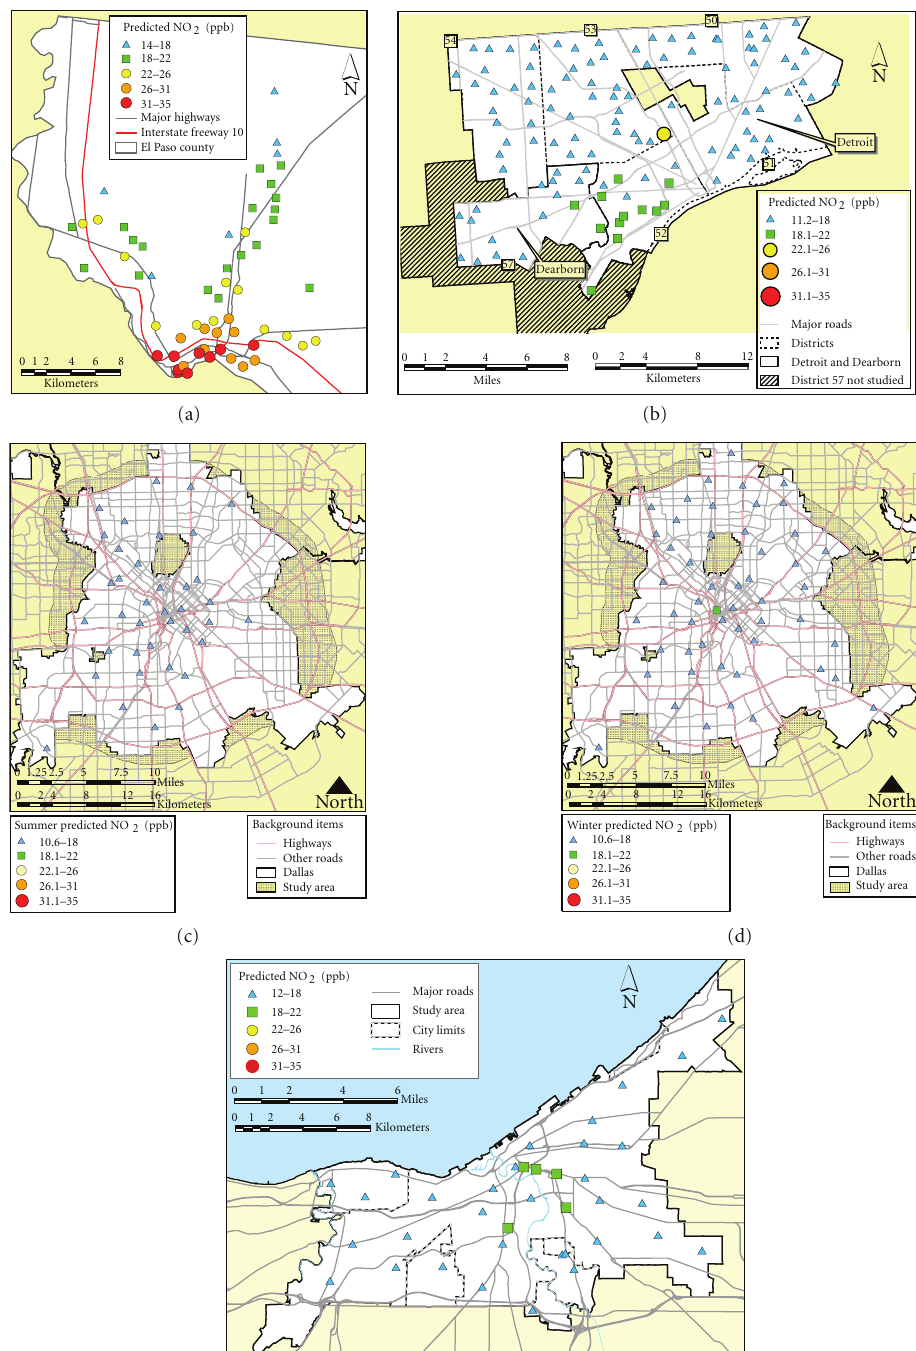
Figure 2: LUR predicted NO 2 concentrations: (a) El Paso; (b) Detroit; (c) Dallas summer; (d) Dallas winter; (e) Cleveland (average of summer and winter). NO 2 gradients are the same scale in all cities for comparison.